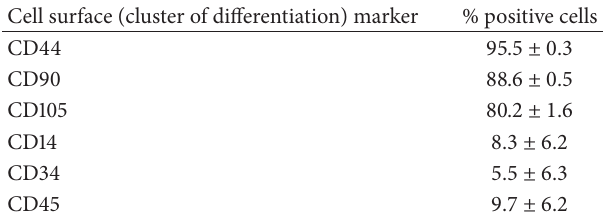
Table 1: Mesenchymal stem cells markers identified by flow cyto- metric analysis.